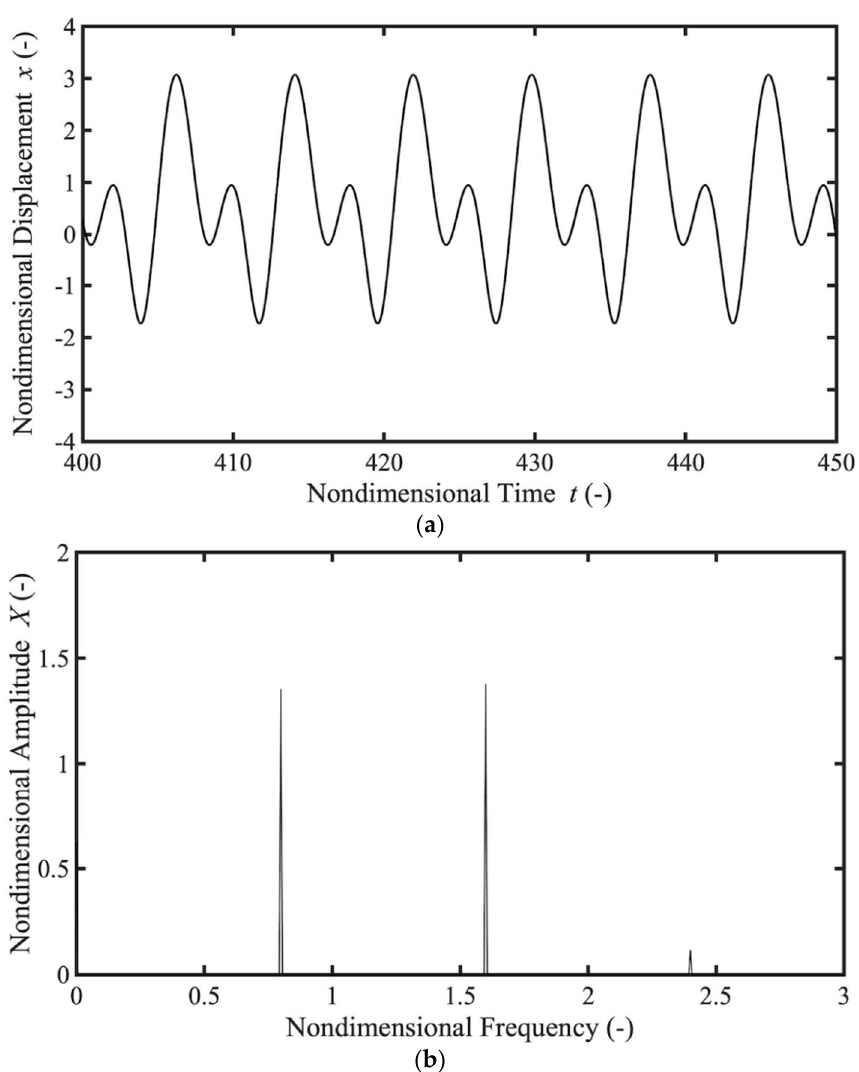
Figure 7. Numerical results of the motion of the magnet above the superconductor excited with the amplitude (cid:1827) = 1.0 mm and frequency (cid:2021) = 1.6 using the series-type shunt damper, showing sub- the amplitude A = 1.0 mm and frequency ν = 1.6 using the series-type shunt damper, showing harmonic resonance. ( a ) Time history; ( b ) FFT. subharmonic resonance. ( a ) Time history; ( b )